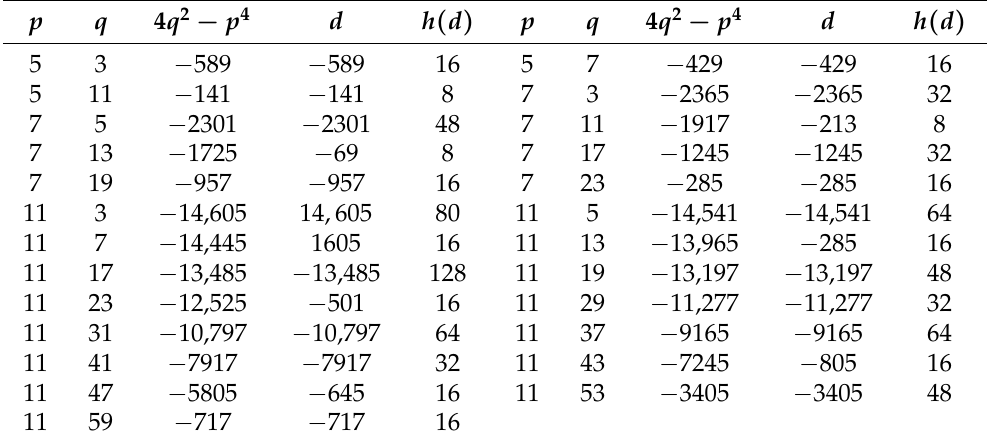
Table 2. Numerical examples for n = 4.